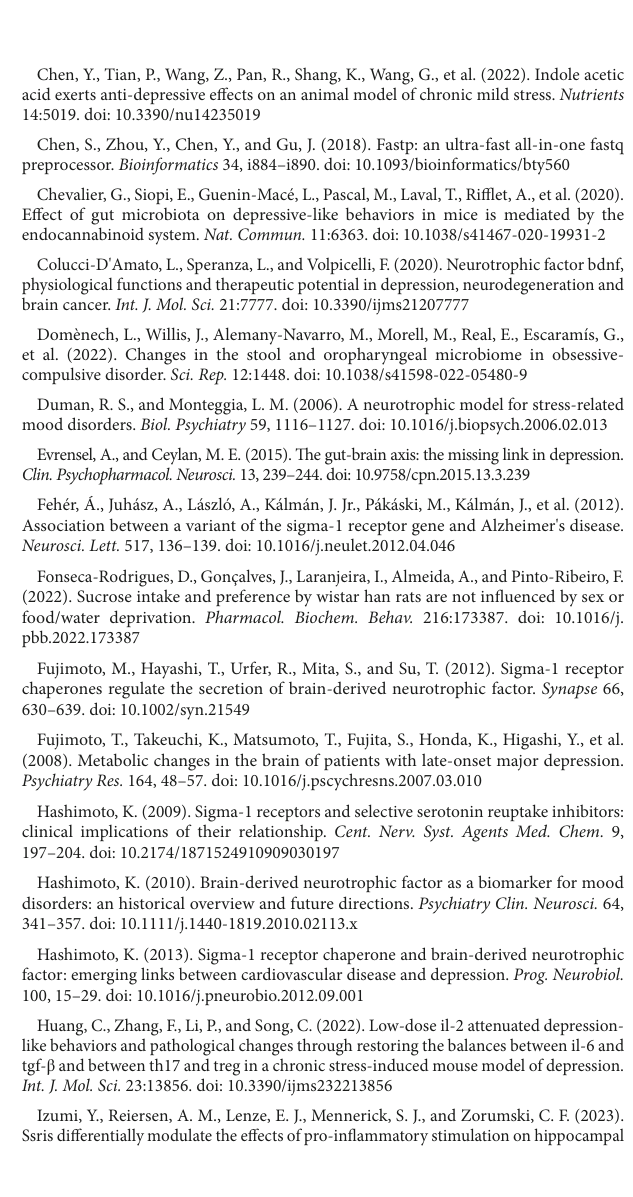
PPCR rewsults of Sig-1R KO mice genotype